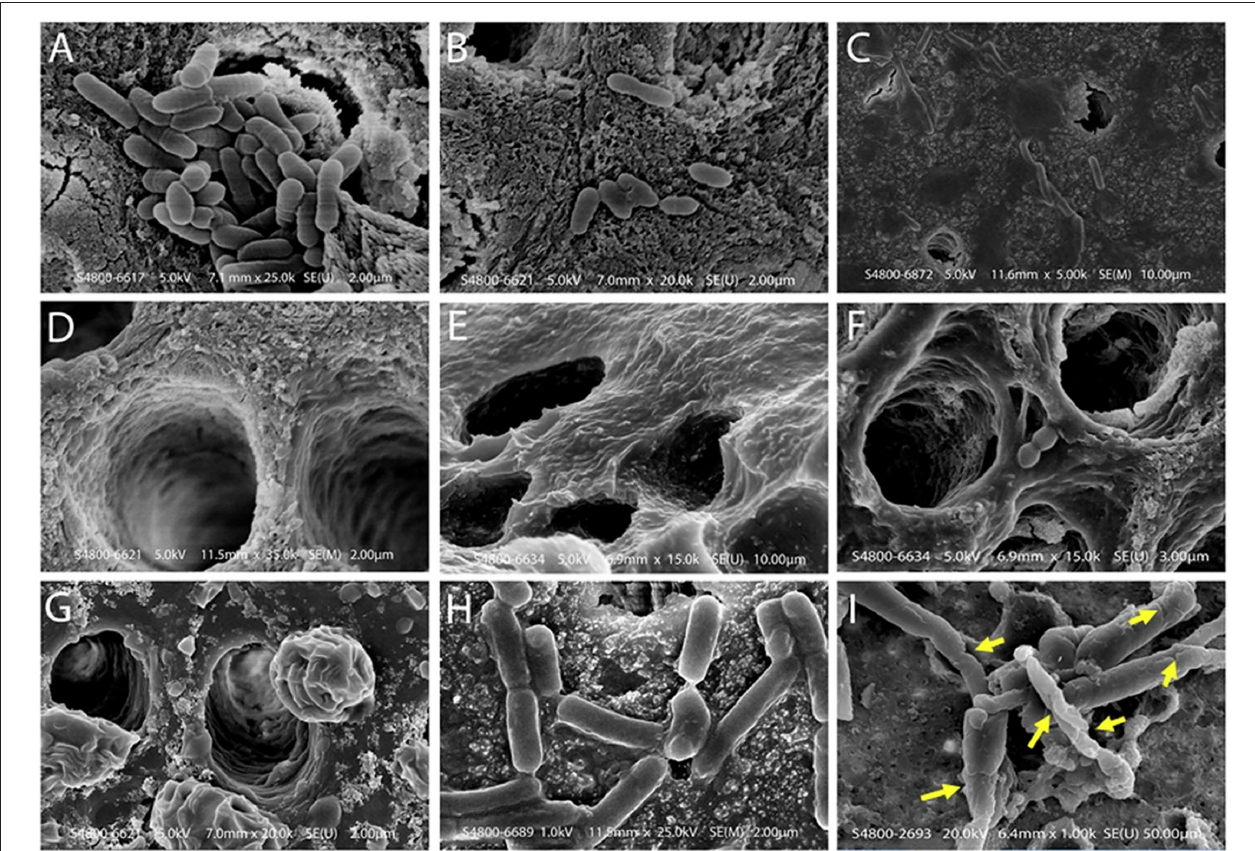
FIGURE 5 | Scanning electron microscope images of dentin samples treated with biofilm and test solutions. (A) A scanning electron microscope of a control specimen, showing dentinal tubules covered with the dual species biofilm. Bacteria and debris are present on the dentine surface without using standard experimental disinfection. Bacteria blocked the opening of the dentinal tubules; groups displayed singular or multiple deposits on the sample with bacterial cells clumping and chaining to form complex biofilms. (B) SEM showing incomplete removal of bacteria on the dentine surface after using 2% CHX protocol. These dentinal tubules are located in the middle third of the dentine specimen. There were small colony chain formations seen among 2% CHX specimens (B) due to slight restructuring as compared to maximum detachment seen in QAS groups. (C,D) Bacterial penetration is limited across the lengths of dentinal tubules and the dentinal surface demonstrated in 1% and 2% QAS specimens. (D) The tubule wall of demineralized dentine treated with 1% QAS shows exposed fibrillar collagen network. (E,F) Representative SEM images of etched dentine following application of 1% and 2% QAS, respectively, showing the QAS molecules did not completely infiltrate into the demineralized collagen matrix, forming a crust on the surface. A phase separation is seen due to the presence of water (G) . (H) Bacterial biofilms were generally intact within control specimens; (I) the bacterial Lactobacillus within the biofilm showed rough and wrinkled surfaces observed on the membrane after treatment with 1% QAS. There were large, damaged areas, including the formation of holes inducing significant damage to the membrane of bacterial cells after use of 1% QAS (I) . Reprinted from Daood et al.